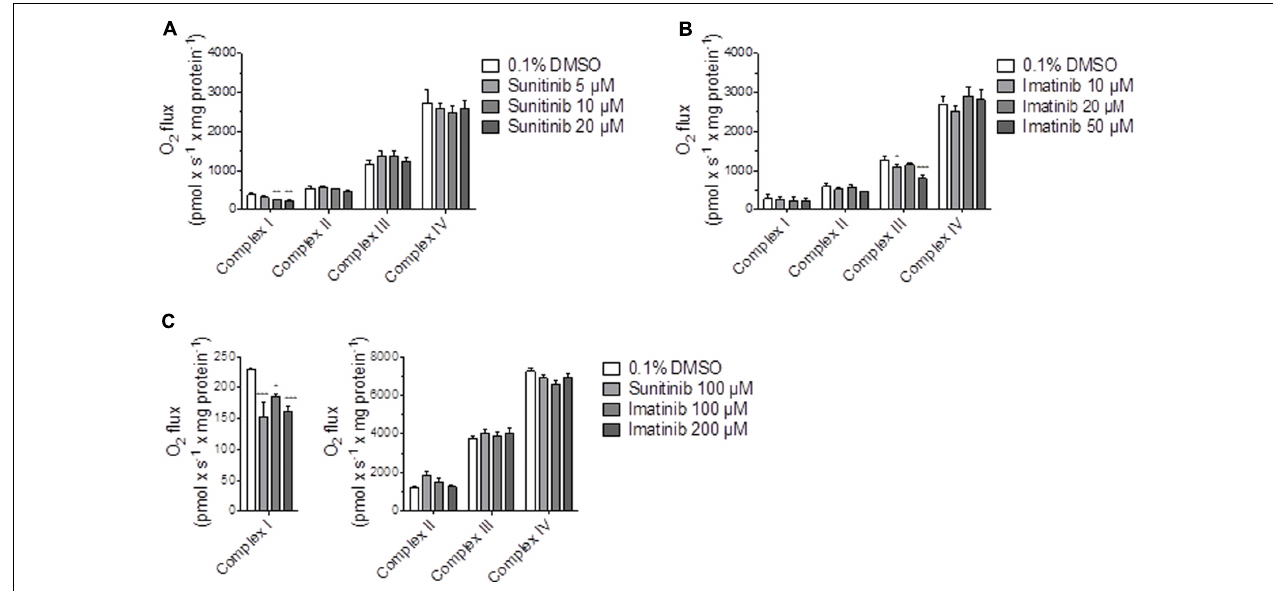
FIGURE 5 | Effect on respiratory capacities through complexes I, II, III, and IV measured on the Oxygraph-2k-high-resolution respirometer. (A,B) Effect on HepG2 cells cultured with galactose after sunitinib and imatinib exposure for 48 h. (C) Effect on isolated mouse liver mitochondria after exposure for 15 min. Data represent the mean ± SEM of at least three independent experiments. ∗ p < 0.05, ∗∗ p < 0.01 or ∗∗∗ p < 0.001 versus DMSO